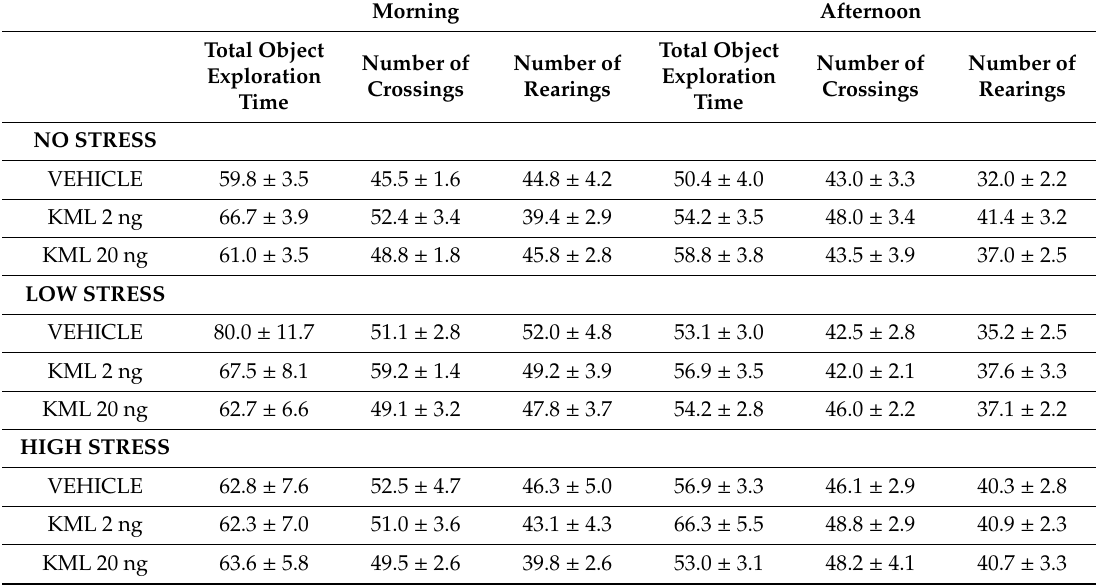
Table 1. Exploratory behavior on the training trial for vehicle- and KML29-treated rats that were subjected to no, low or high stress conditions immediately after the training trial, in the morning or